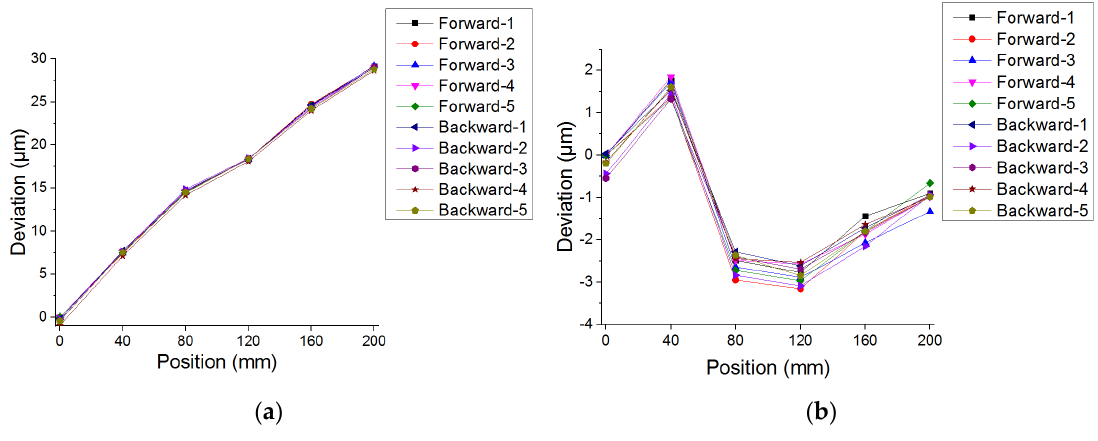
Figure 11. Linear displacement calibration of the machine tool: ( a ) Without compensation and ( b ) with compensation.